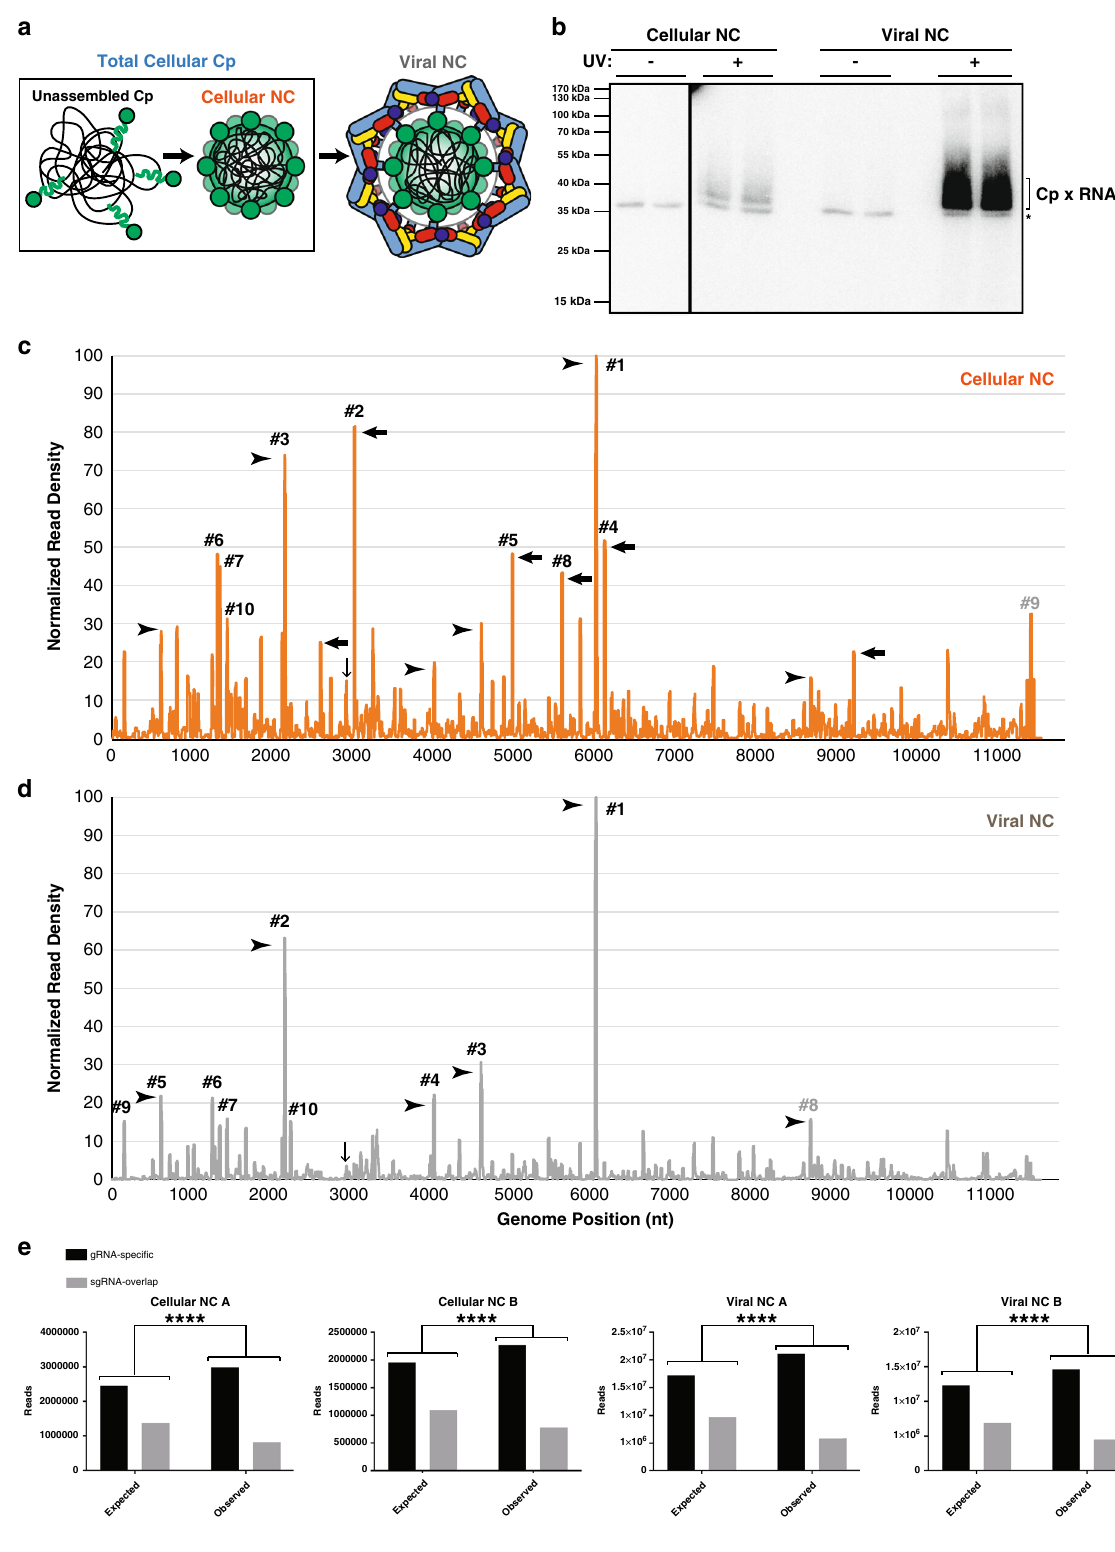
(1:1 Cp:RNA) or in the presence of 10mer DNA (1:20:1 Cp:10mer: RNA) showed a single peak centered toward the middle of the gradient (Fig. 6c), consistent with previous sucrose gradient sedimentation analyses 21 . Thus, Cp robustly assembles into CLPs with site #1 RNA even in the presence of an excess of electrostatic competitor nucleic